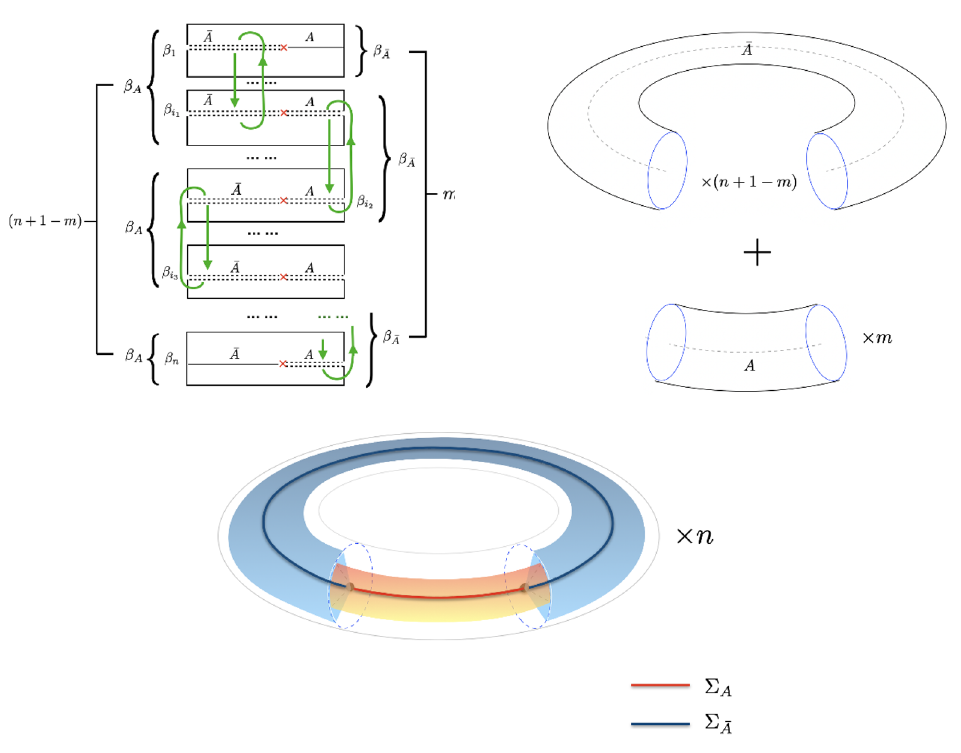
Figure 7 . Top-left: a generic planar M i 2 fM m g . Top-right: a generic bulk saddle B m for fM m g . Bottom: the quotient geometry ~ B m = B m = Z n , obtained by the double-defect